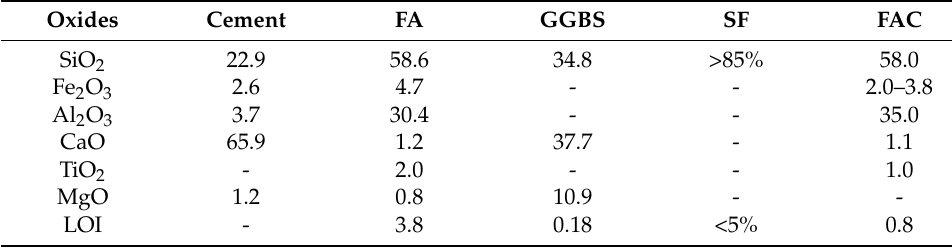
Figure 2. ( a ) Morphology of FAC particles; and ( b ) their hollow core-shell structure. Table 1. Chemical compositions of raw materials in wt.